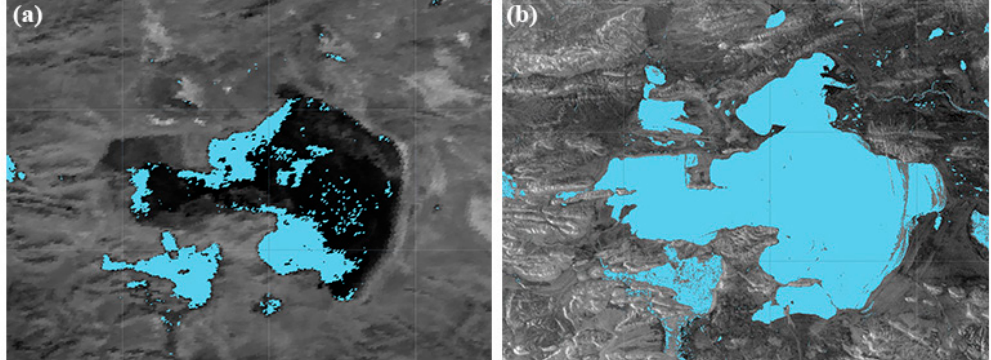
Figure 10. The map of Selinco Lake and small water body in January 2016 in ( a ) inland surface water dataset in China (ISWDC) and ( b ) high spatial-temporal water body dataset in China (HSWDC).